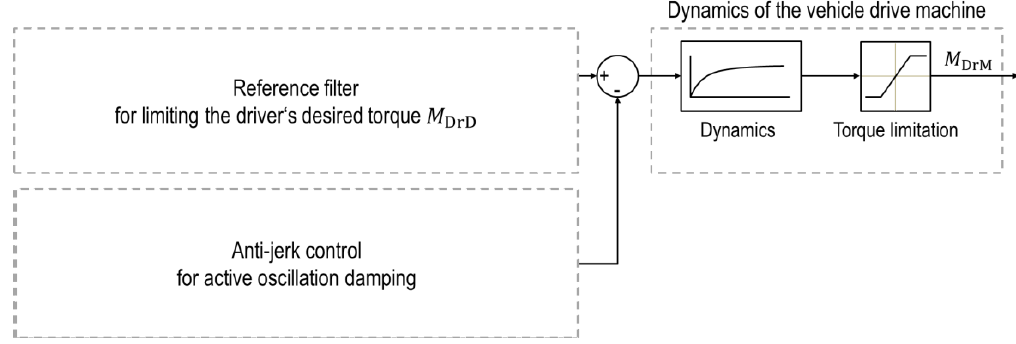
Figure 5. Drivability function and dynamics of the vehicle drive machine.